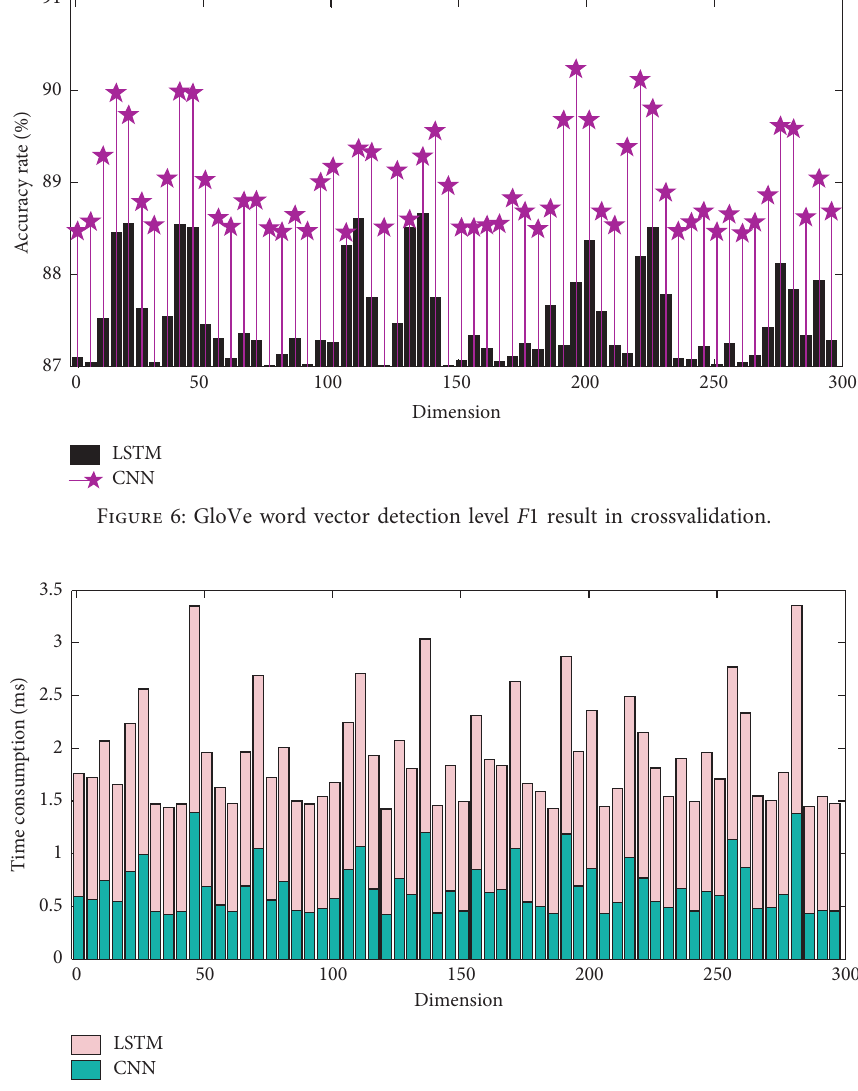
Figure 7: The time consumption of F 1 in the detection stage of the CNN classifier and LSTM classifier in different dimensions.